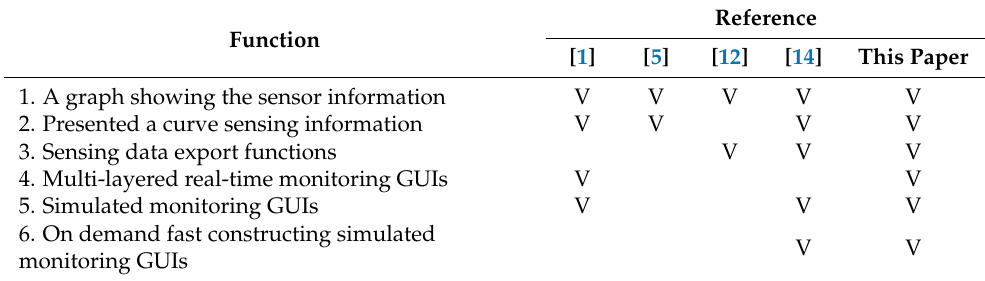
Table 3. Function comparison of monitoring graphical interfaces in different